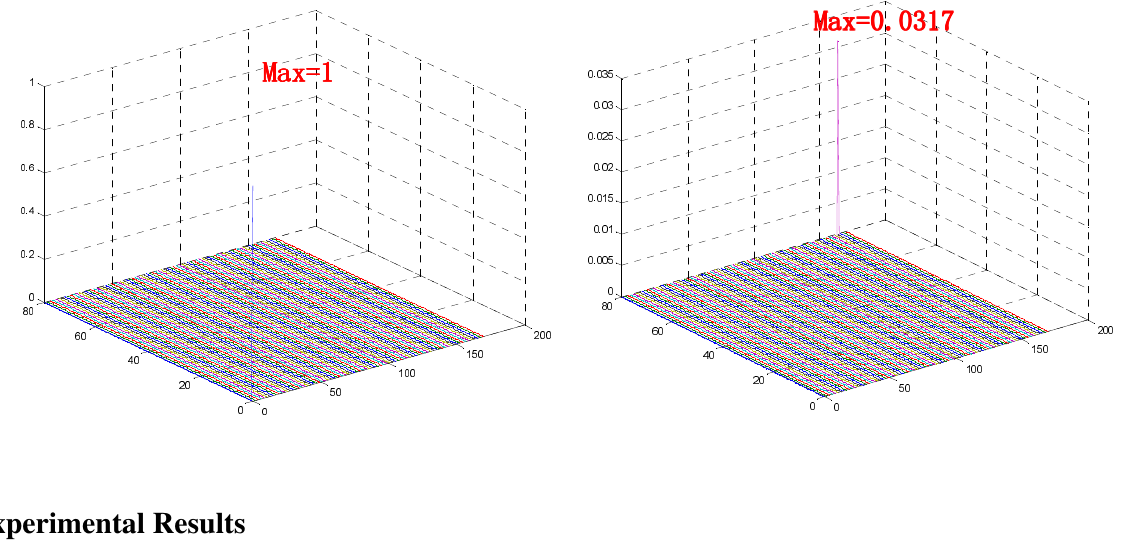
Figure 8. POC measure. Left: r ( x; y ) of two same finger-vein images. Right: r ( x; y ) of two finger-vein images from different